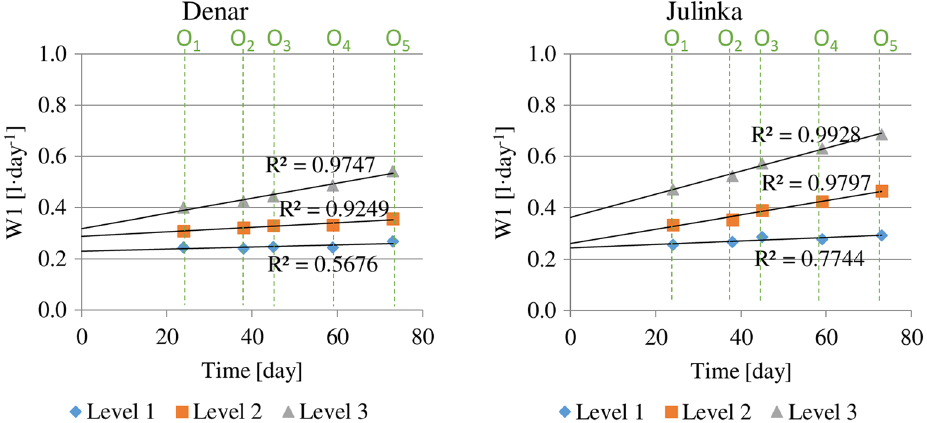
Figure 4. Average daily water consumption for potato varieties, at three soil humidity levels (1, 2, 3) and in each of five growing stages (O1), (O2), (O3), (O4), (O5).